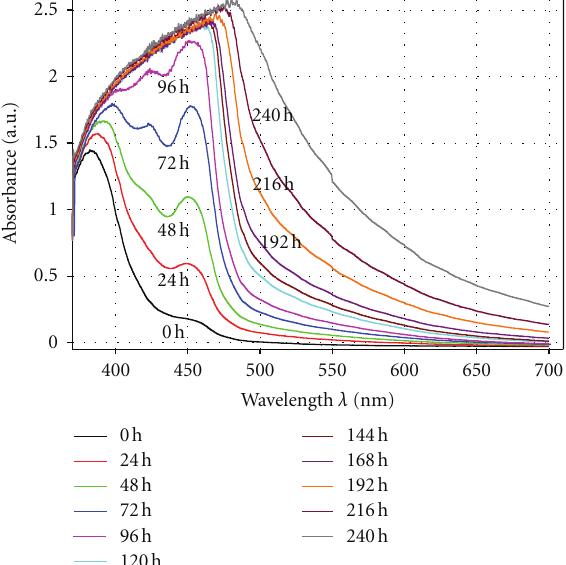
Figure 11: UV-VIS optical transmittance spectra of the T100 oil with di ff erent ages.